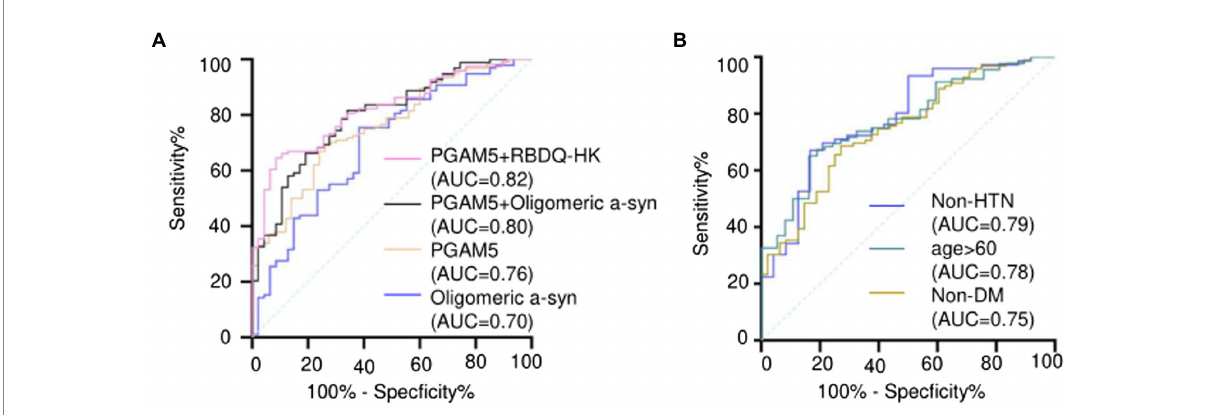
FIGURE 2 (A) ROC curves and AUC of plasma PAMG5 combined with the score of RBDQ-HK or plasma oligomeric α -syn; and ROC curves and AUC of plasma PAMG5 or plasma oligomeric α -syn separately; (B) ROC curves and AUC of plasma PAMG5 in different PD subgroups.